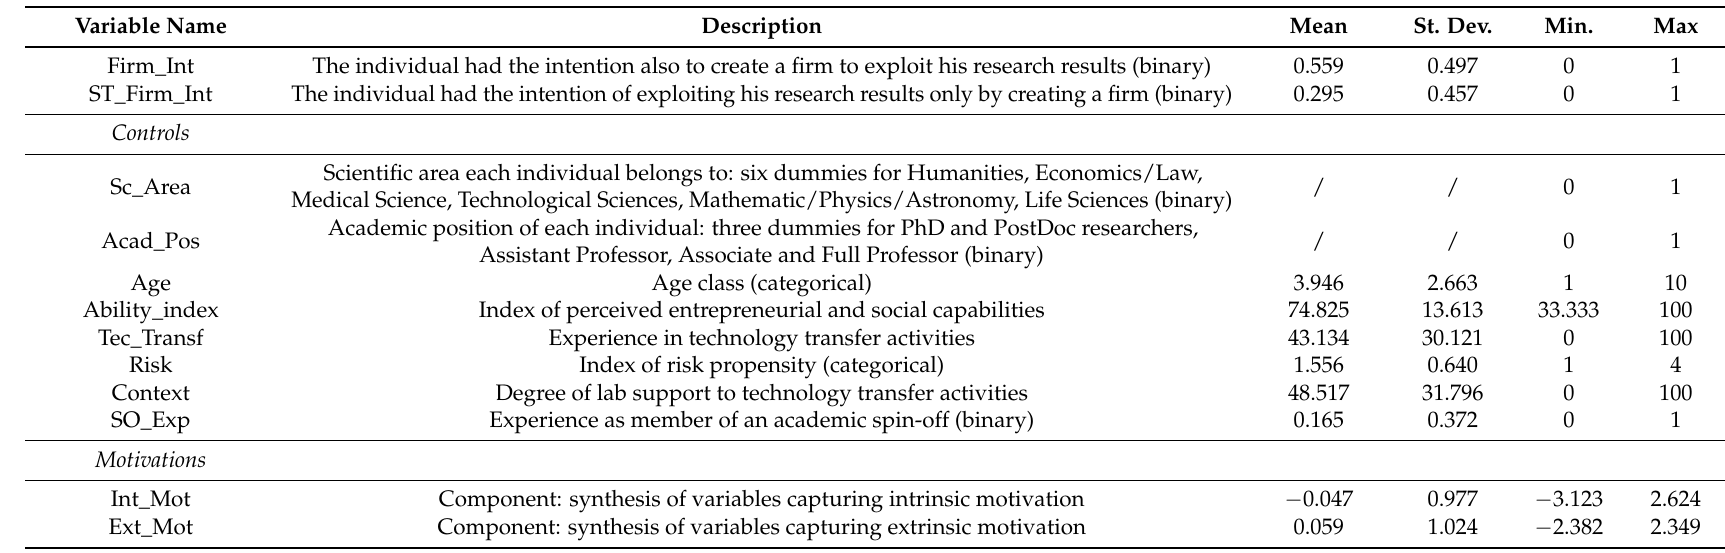
Table 4. Variable description for the main covariates of the econometric